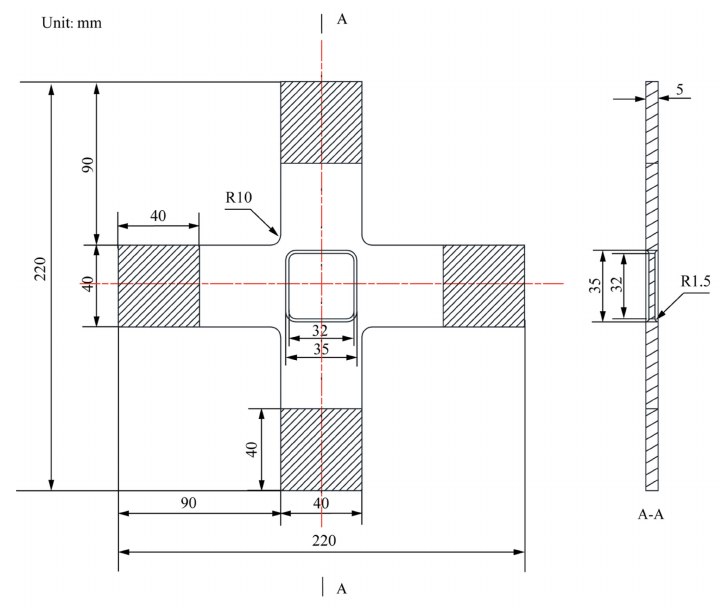
Figure 1. The geometry of the original cruciform specimen.